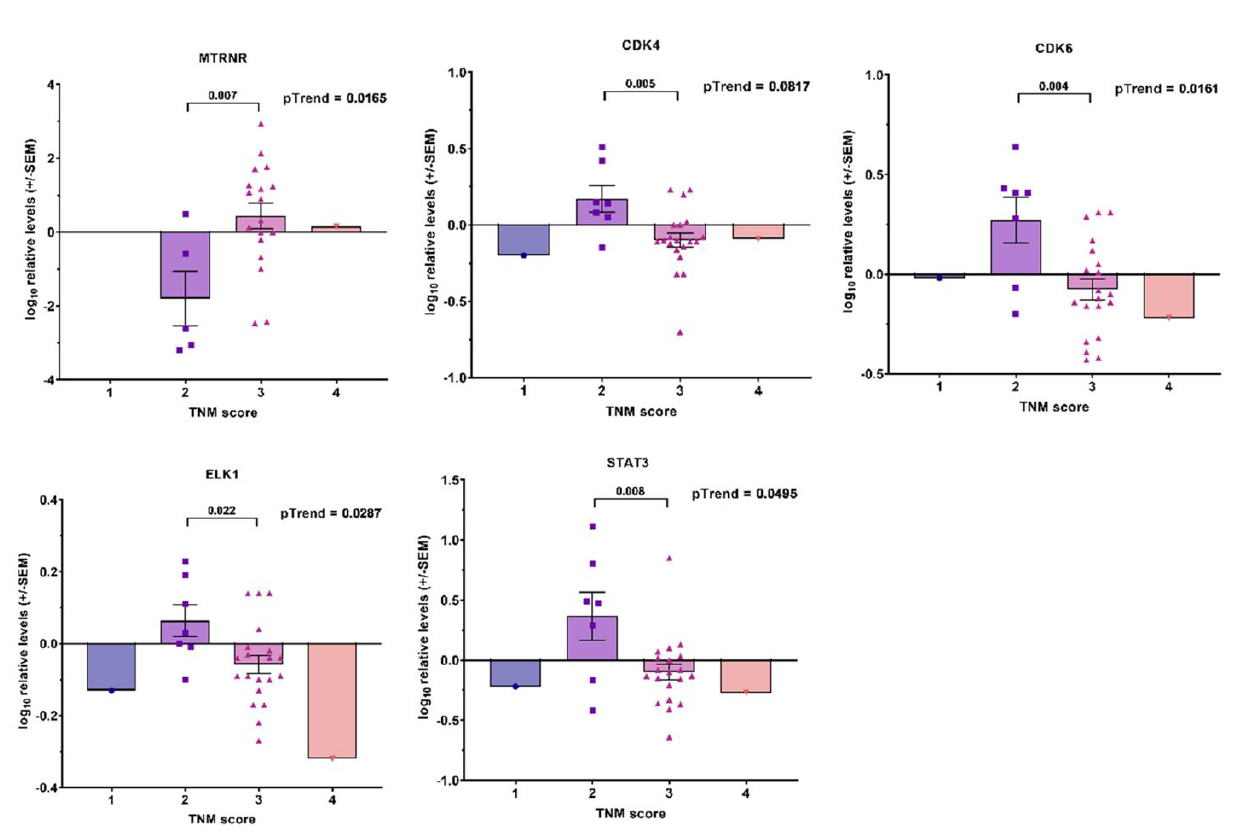
Figure 8. Associations between transcripts’ expression in blood-derived mRNA and TNM score in ADT− cohort. Bar graphs showing − log10 relative expression levels of gene transcripts in different TNM score groups. p values are indicated after linear test for trend following ANOVA or after unpaired t -test between two groups (TNM = 2 and TNM = 3).